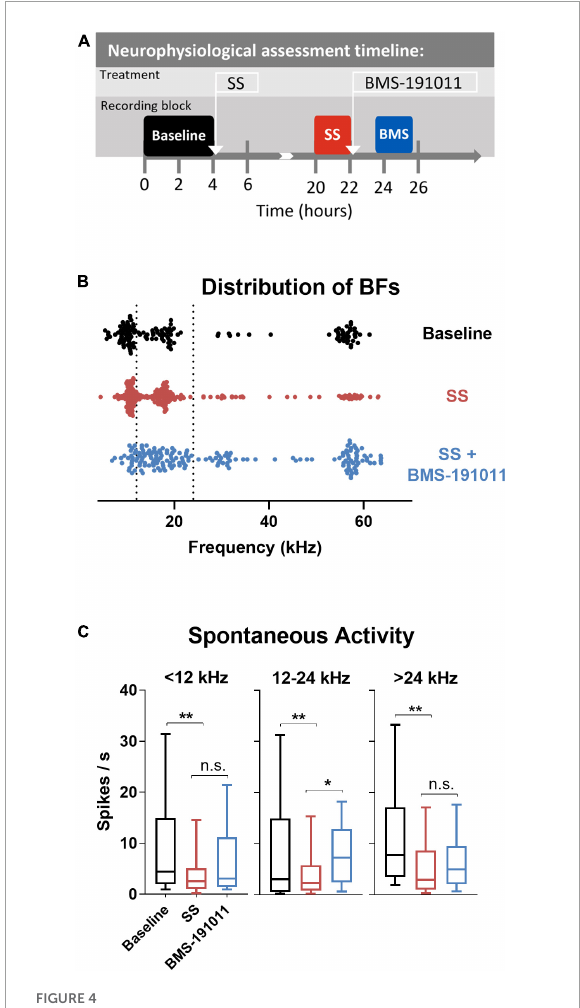
FIGURE4 BMS-191011 treatment reverses spontaneous activity induced by sodium salicylate in the inferior colliculus. (A) Schematic showing the timing of the neurophysiological recordings included in the analysis. Recordings were made prior to I.P. administration of SS (baseline-black), after systemic SS administration (orange), and again after administration of BMS-191011 applied locally over the IC (blue). Between baseline recordings and SS recordings, free movement was allowed in the home cage. Multiple penetrations of the multi-electrode array were used for each timepoint in order to maximize the number of active channels. In the last location neural activity was measured before and after BMS-191011 administration allowing the SS and SS + BMS-191011 effects to be observed in the same neurons. (B) Plot of the best frequencies (BFs) for each recorded IC unit at baseline, after SS administration, and again after BMS-191011 application. The dotted lines demarcates the grouping of units in the subsequent panels. (C) Plots of mean spontaneous spike rates measured at baseline (black), the day after SS administration (orange), and again after BMS-191011 administration (blue). One-way ANOVAs showed a significant effect of treatment for units with BFs < 12 kHz ( F (2,170) = 4.419; p < 0.05), 12 – 24 kHz ( F (2,242) = 6.798; p < 0.01), and > 24 kHz ( F (2,170) = 5.403; p < 0.001). Post-hoc analyses indicated that